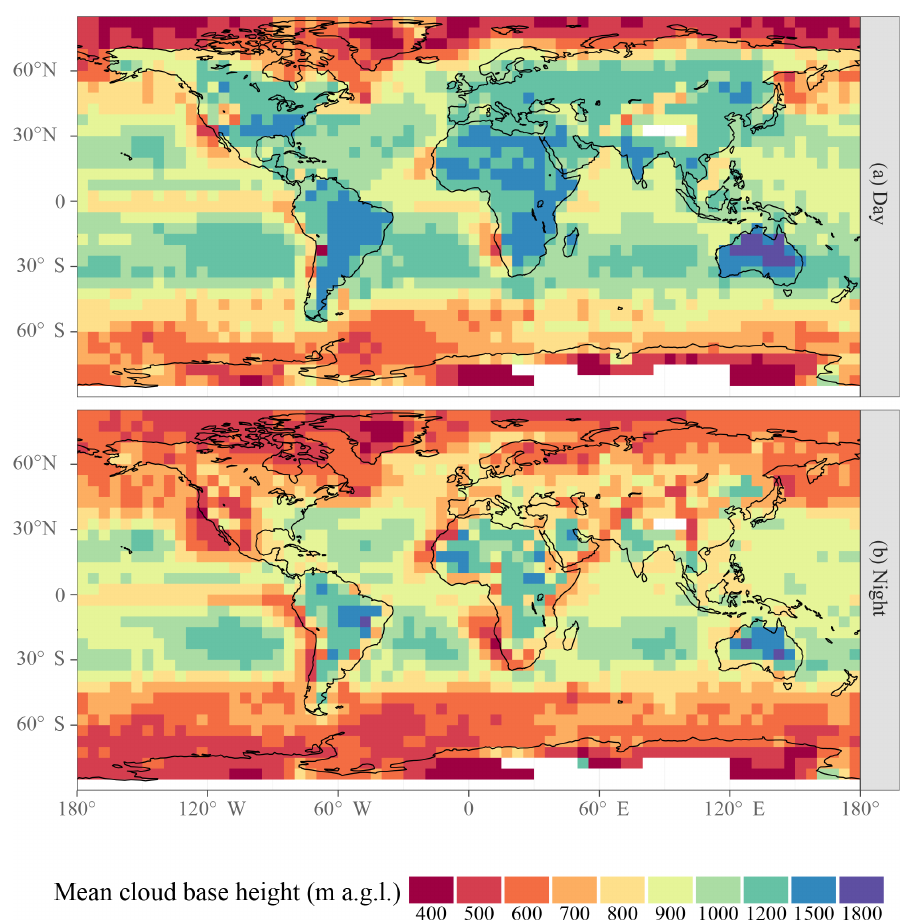
Figure 11. Geographic distribution of mean z above ground level. Statistics are calculated within each 5 ◦ × 5 ◦ latitude–longitude box and separately for CALIOP daytime (a) and nighttime (b) overpasses.